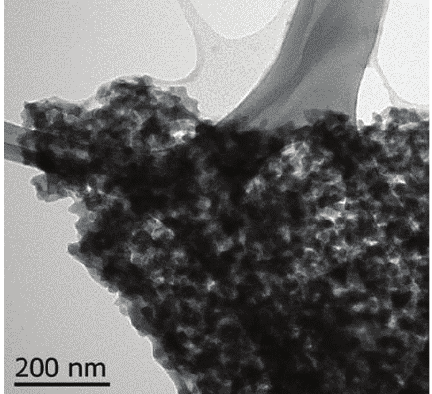
Figure 2: Transmission Electron Microscopy micrograph showing irregular-shaped of SiO 2 nanoparticles with article size between 10–